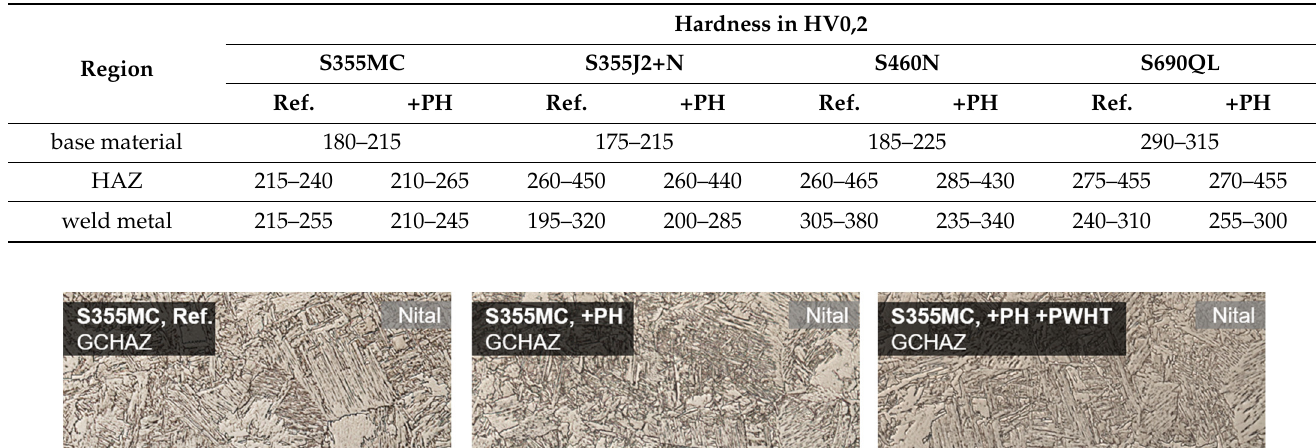
Table 4. Hardness values in specific regions of the bead-on-plate welds, references and with PH.